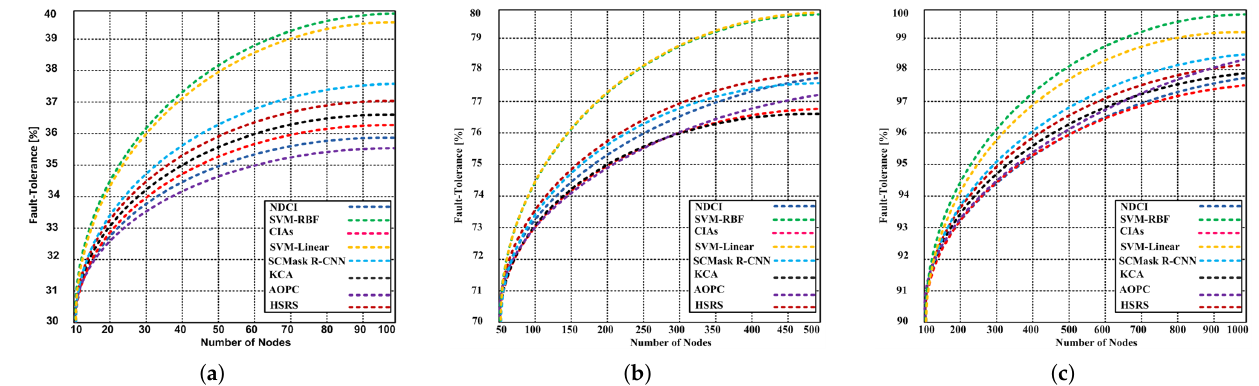
Figure 15. ( a ) Fault-tolerance of the proposed SVM-RBF and SVM-Linear variants and contending algorithm (NDCI, SCMask R-CNN, CIAs, KCA, HSRS, and AOPC) with maximum 100 nodes using thermal remote image sensing; ( b ) Fault-tolerance of the proposed SVM-RBF and SVM-Linear variants and contending algorithm (NDCI, SCMask R-CNN, CIAs, KCA, HSRS, and AOPC) with maximum 500 nodes using thermal remote image sensing; ( c ) Fault-tolerance of the proposed SVM-RBF and SVM-Linear variants and contending algorithm (NDCI, SCMask R-CNN, CIAs, KCA, HSRS, and AOPC) with maximum 1000 nodes using thermal remote image